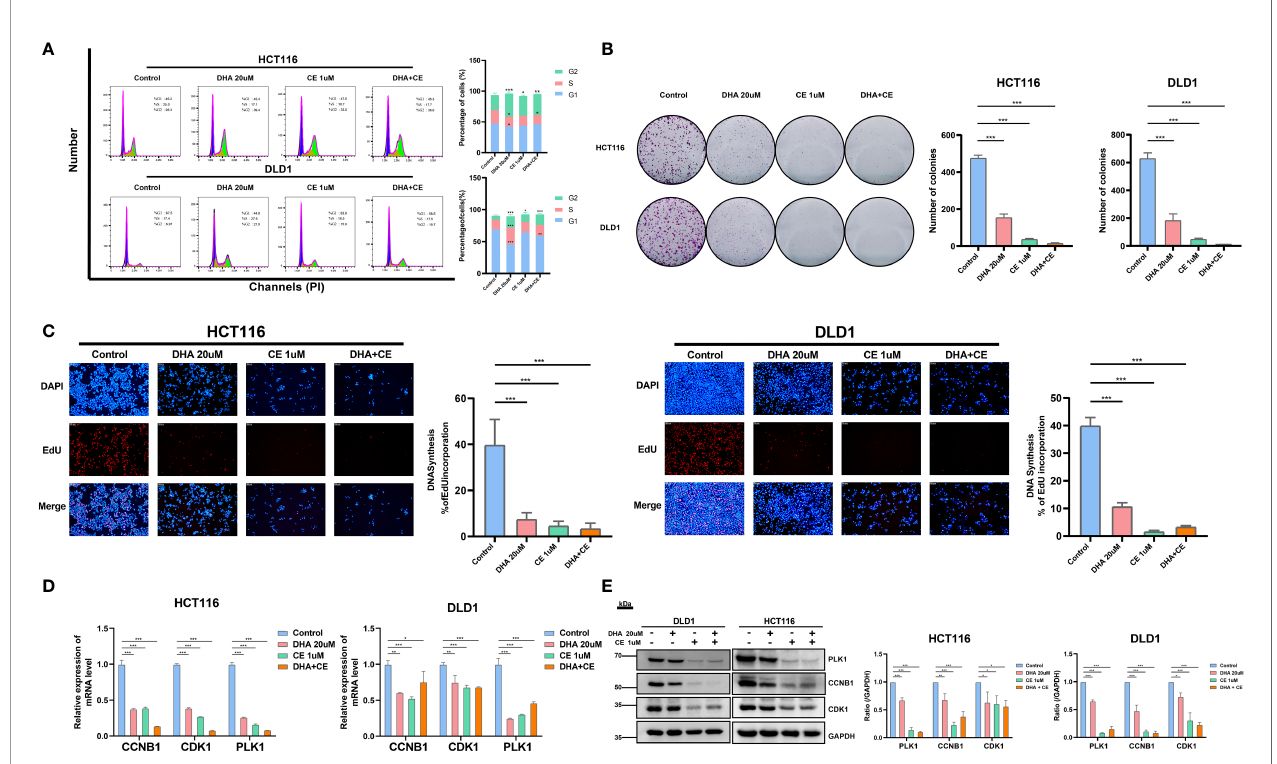
FIGURE 5 | DHA synergizes with cucurbitacin E to inhibit the growth of CRC cells. (A) The effects of DHA and CE on cell cycle distribution were examined by fl ow cytometry. (B) The effects of DHA and CE on cell colony formation were illustrated by the cell colony formation assay. (C) The effects of DHA and CE on DNA synthesis were examined by EdU assay. (D, E) qRT-PCR and Western blotting analysis of the effects of DHA and CE on the expression of CDK1, CCNB1, and PLK1 in CRC cells. Data are shown as means ± SD. *p < 0.05, **p < 0.01, ***p < 0.001. DHA, dihydroartemisinin; CRC, colorectal cancer; CE, cucurbitacin